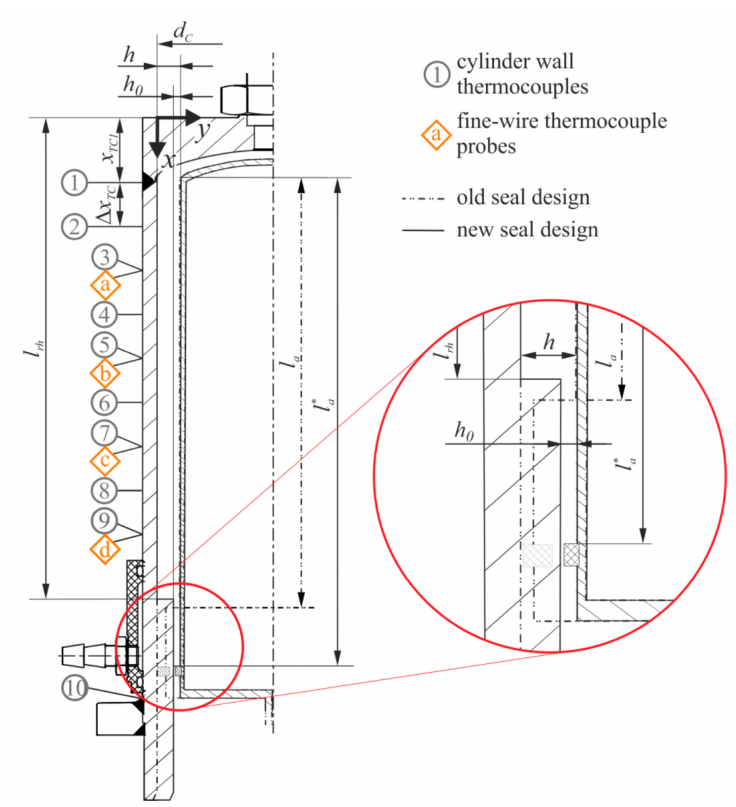
Figure 2. Axial positions of fine-wire and wall thermocouples and illustration of old seal design (dashed double dotted lines) and new seal design. Table 1. Nominal operating conditions and geometric dimensions of the laboratory-scale machine